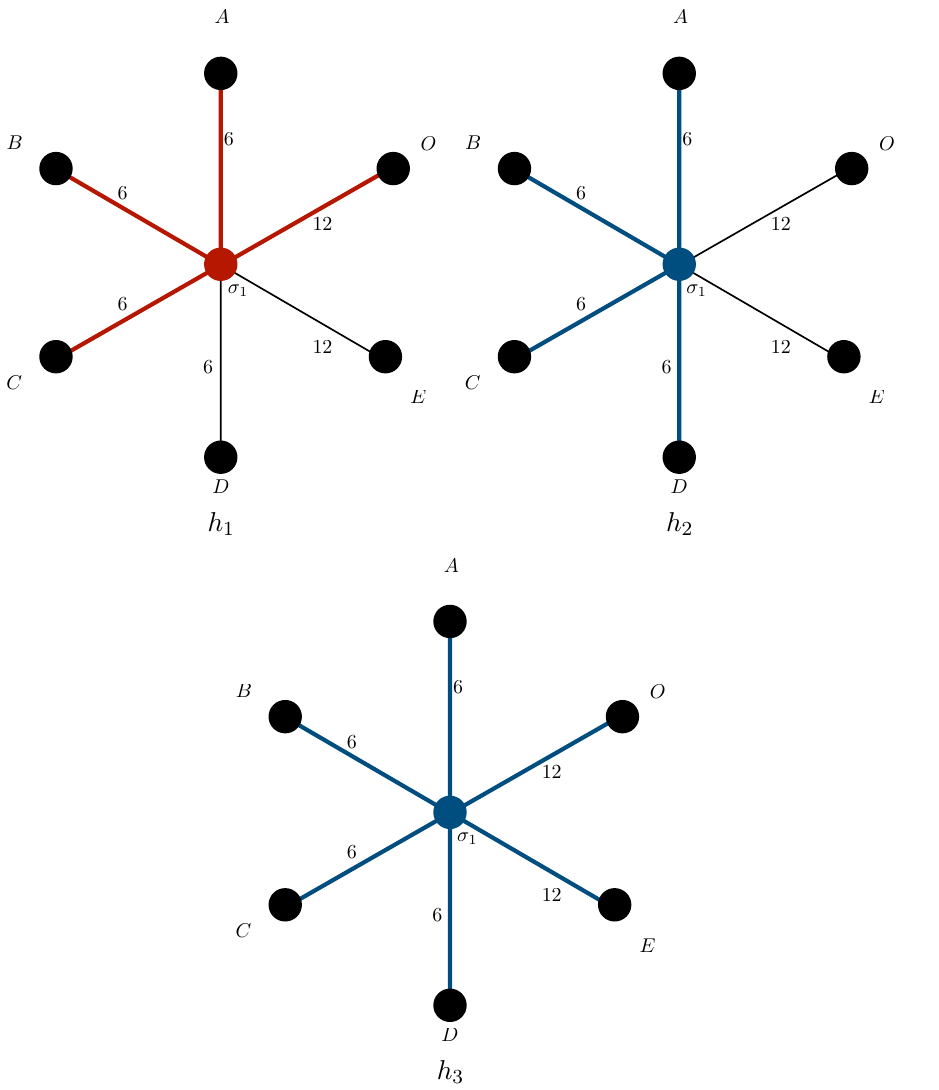
Figure 24 . The thread configuration consists of three classes of threads h 1 , h 2 and h 3 which are collections of thread species which respect a symmetry of the graph. h threads one between each of ( ABCD ) each of ABCD, ( ABCD )